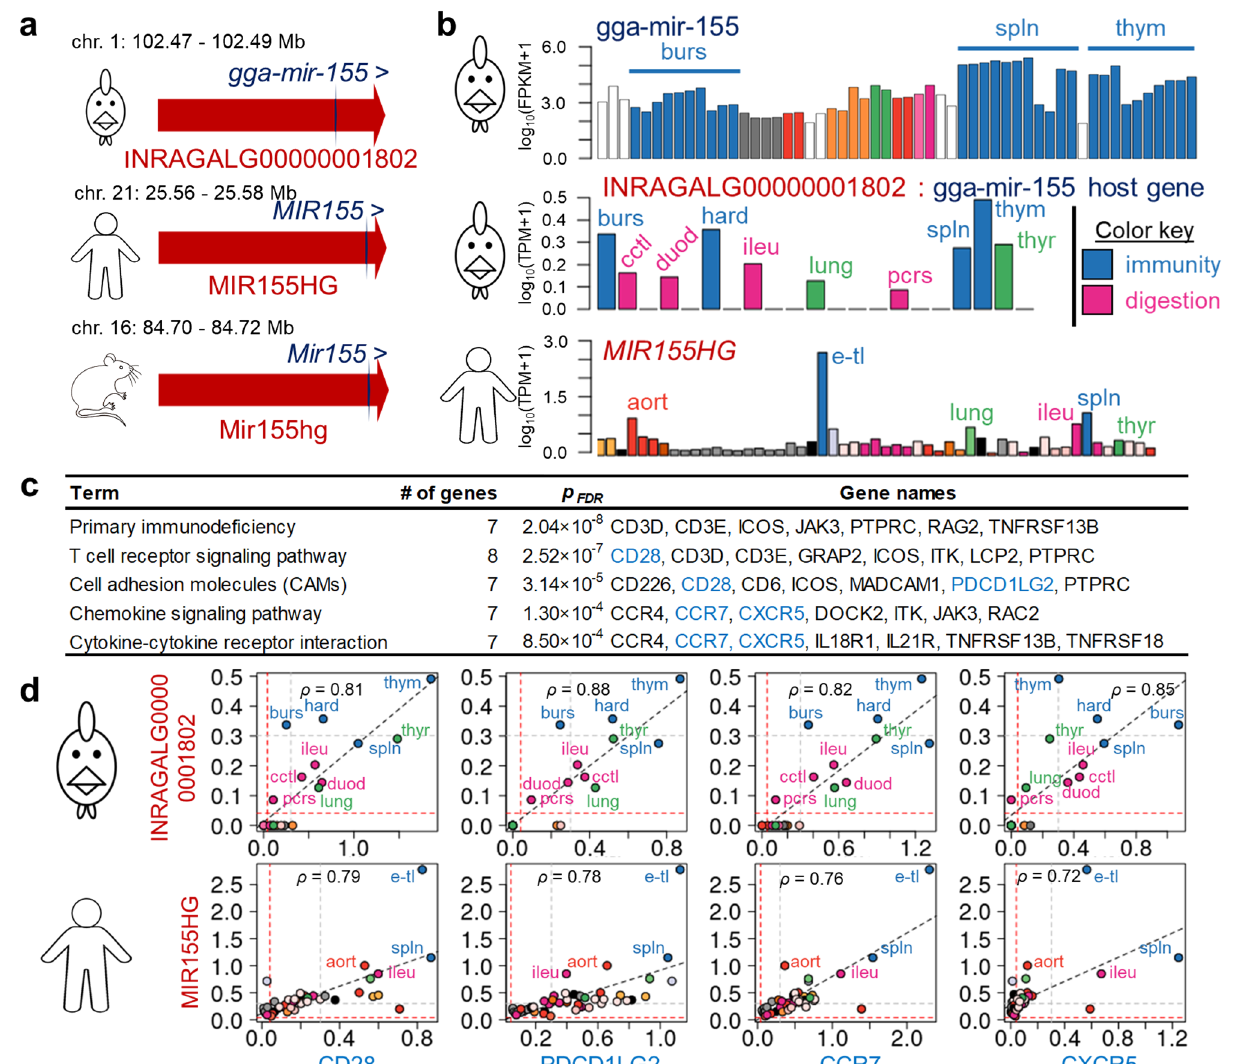
Figure 4. Conservation of genomic location and function of a miR host LNC across species. ( a ) INRAGALG00000001802 hosts gga-mir-155 and is conserved in human (MIR155HG) and mouse (Mir155hg). ( b ) Gga-mir-155 (top) and its host LNC, INRAGALG00000001802 (middle), are mostly expressed in immunity- related tissues in chicken, similarly to MIR155HG in human (bottom). Gga-mir-155 expression is expressed in log 10 (FPKM + 1) and the 55 Chickspress database tissues are ordered as the list available in Supplementary Table S22A, INRAGALG00000001802 and MIR155HG expressions are expressed in log 10 (TPM + 1) and the 53 GTEx project tissues are ordered as the list available in Supplementary Table S22B ( c ) Top 5 enriched KEGG terms supported by more than 5 genes associated to the PCG correlated to INRAGALG00000001802. PCG in blue are used in next panel. ( d ) Co-expression of four PCG from previous panel with INRAGALG00000001802 in chicken (top) or MIR155HG in human (bottom). Abbreviations in panels ( b ) and ( d ) stand for: aort: